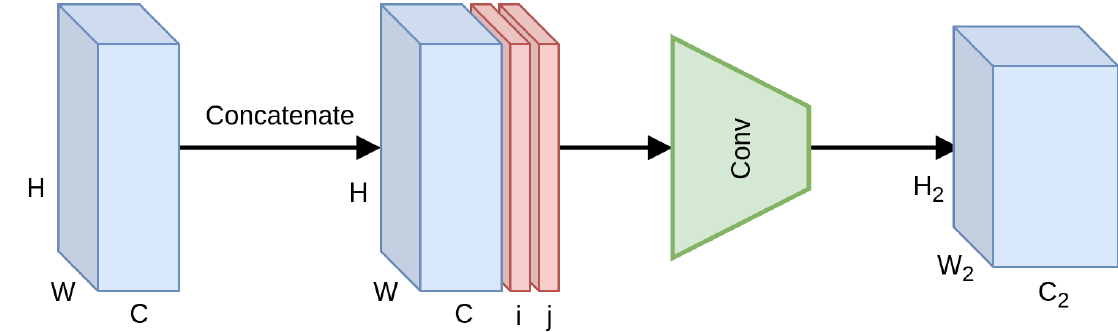
Figure 6. Schematic representation of the CoordConv module.